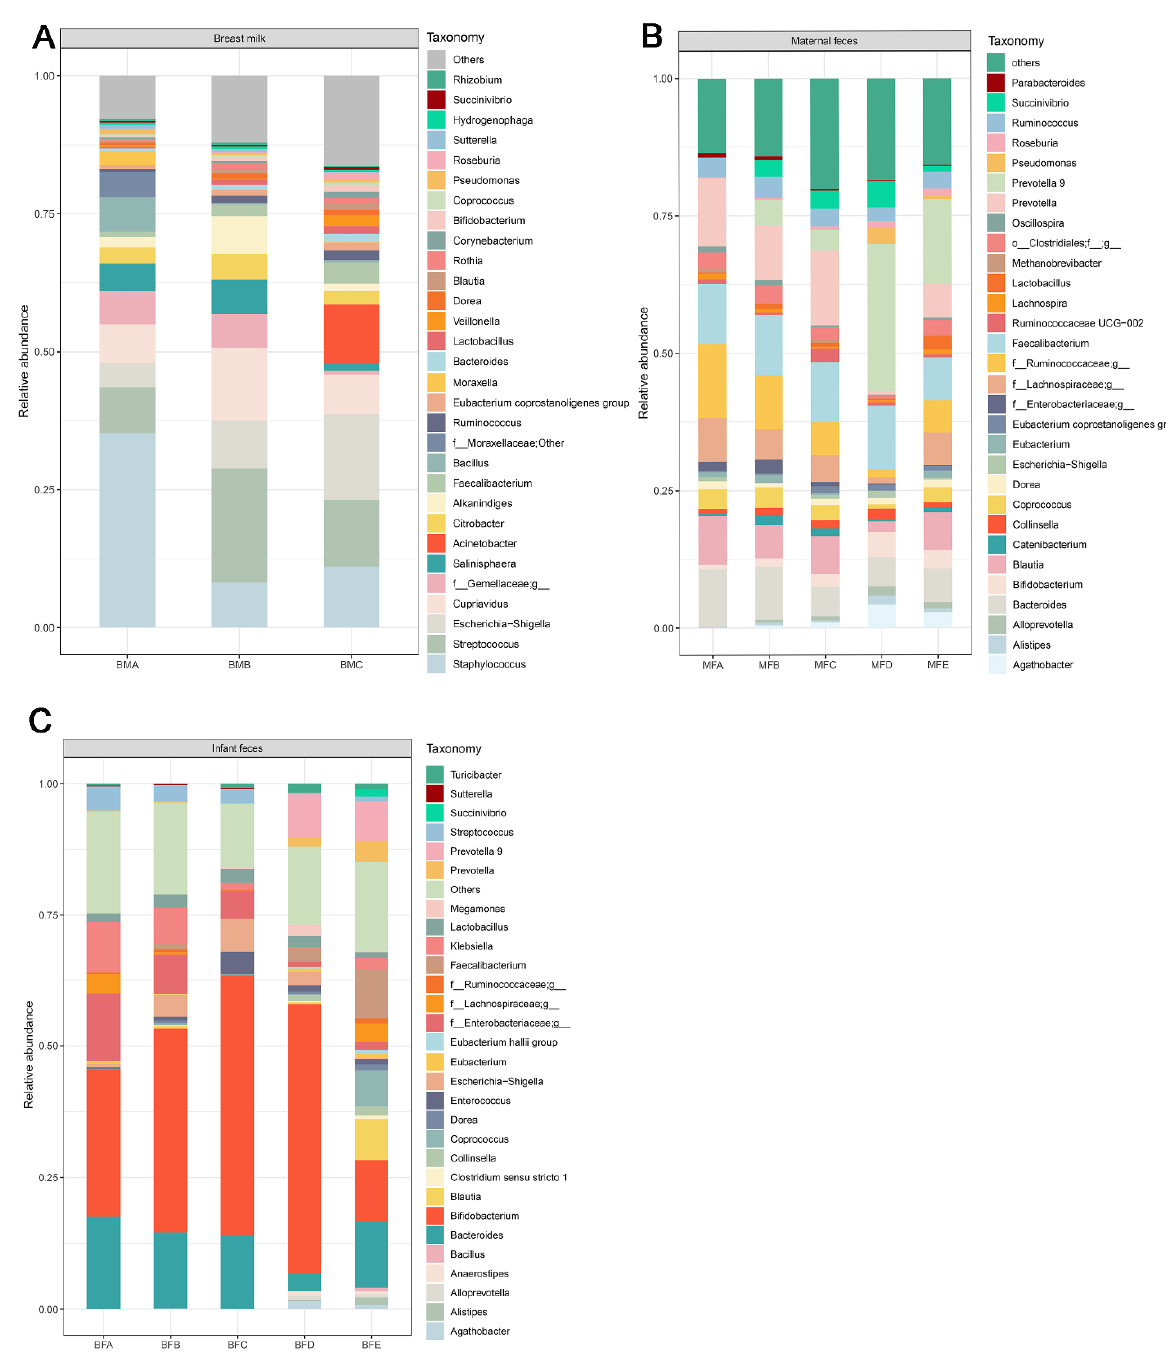
Figure 3. Top 30 genera in human breast milk, maternal and infant feces. ( A ) human breast milk; ( B ) maternal feces; ( C ) child’s feces. BMA: breast milk (corresponding to infant younger than one month of age), BMB: breast milk (corresponding to infant between 1 and three months of age), BMC: breast milk (corresponding to infant between three and six months of age), MFA: maternal feces (corresponding to infant younger than one month of age), MFB: maternal feces (corresponding to infant between 1 and three months of age), MFC: maternal feces (corresponding to infant between three and six months of age), MFD: maternal feces (corresponding to infant between six and 12 months of age), MFE: maternal feces (corresponding to infant older than 12 months of age), BFA: infant feces younger than one month of age, BFB: infant feces between 1 and three months of age, BFC: infant feces between three and six months of age, BFD: infant feces between six and 12 months of age, BFE: infant feces older than 12 months of